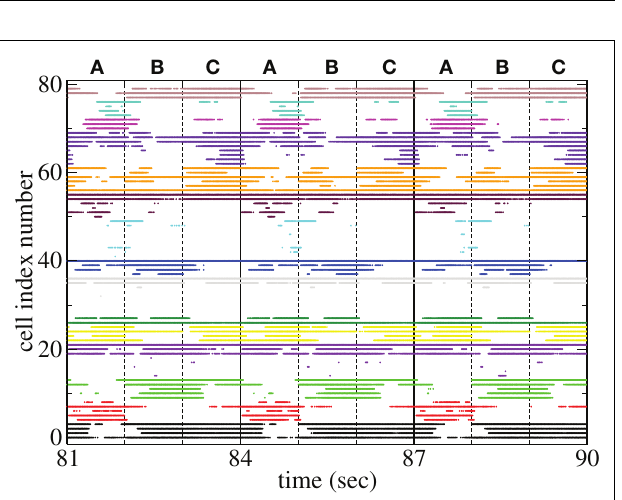
FIGURE 9 | 500 cell network simulations under variation of input strength at low connectivity ρ = 0.1, b C = 0.001, α = 5, but faster inhibitory neurotransmitter decay time τ g = 20. Each point is calculated from a 50-s time series from a different network simulation. Black solid circles – mean CV over all cells. Red solid squares – mean CV of k-means generated clusters. Green solid diamonds – mean CV of randomly generated clusters.